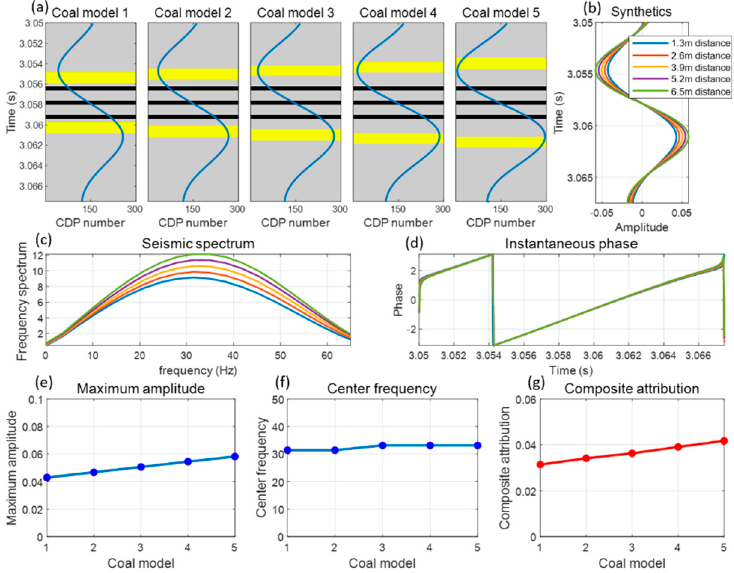
Figure 3. Model of thin coal seams coupled with sandstone and its synthetics and attributes: ( a ) coal model, ( b ) synthetic, ( c ) seismic frequency spectrum, ( d ) instantaneous phase, ( e ) maximum ampli- tude, ( f ) centre frequency, and ( g ) composite attribute.